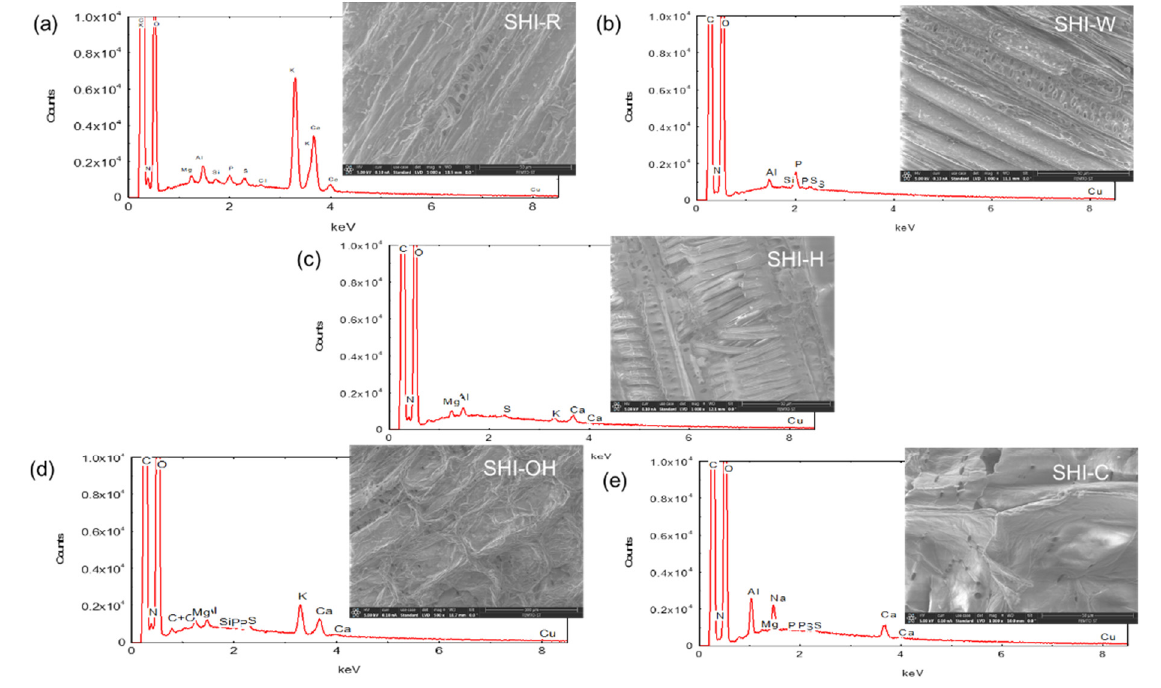
Figure 5. Elemental analysis using EDX spectra and SEM images of untreated SHI-R ( a ) and treated SHI-W, SHI-H, SHI-OH and SHI-C ( b – e ) hemp shives.